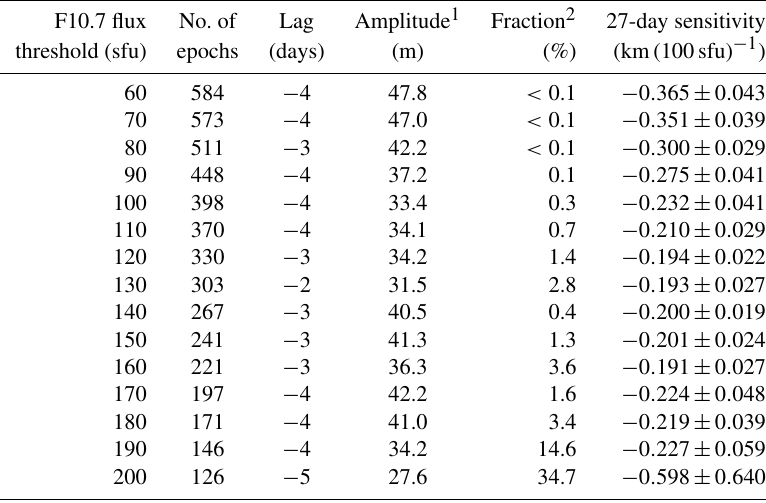
Table 1. Overview of the results for different solar activity thresholds. F10.7 flux No. of Lag Amplitude 1 Fraction